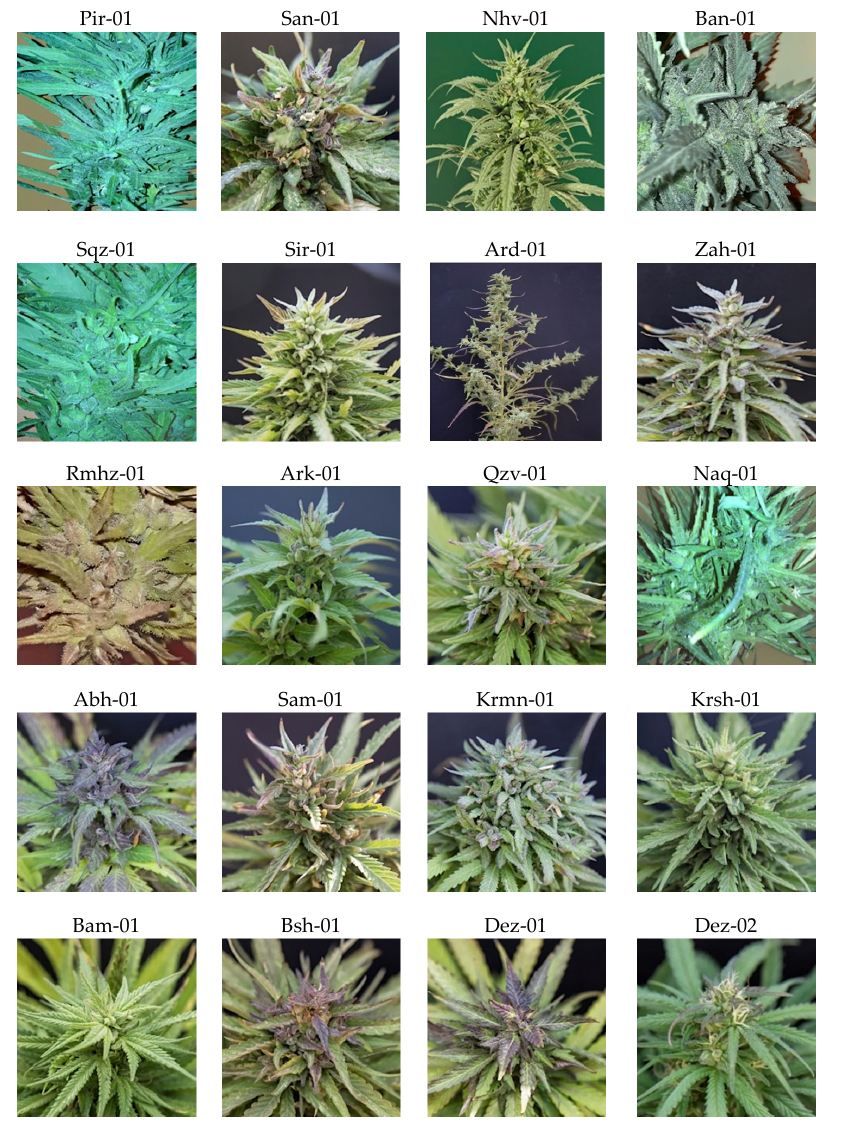
Figure 1. Diversity in female inflorescence of 20 natural cannabis populations distributed across Iran from west and north-west to south-west and east and south-east.